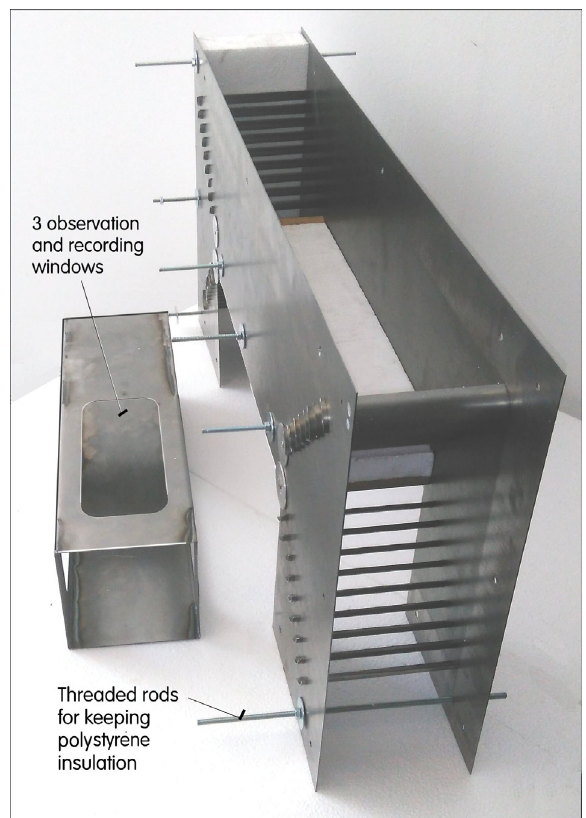
Fig. 26. Photograph of the two components of the tunnel. The polystyrene foam thermal insulation cladding will be held on the threaded rods seen in this photograph. The cladding will leave for the air flow the flowpath as seen in Fig.